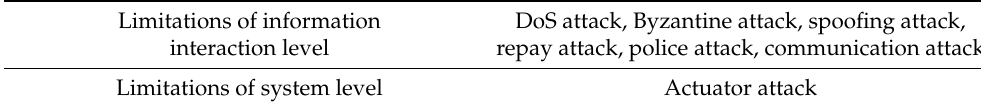
Table 1. Classification of common cyber attacks of MASs.